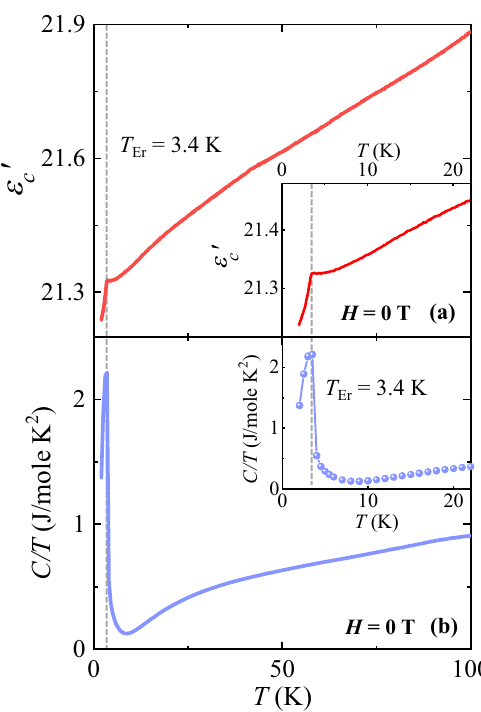
Figure 3. Temperature-dependent dielectric constant and specific heat. ( a ) Temperature dependence of dielectric constant, measured along the c axis ( ε c ′ ) at H = 0 T. Inset shows the low-temperature regime of ε c ′ . ( b ) Temperature dependence of the ratio of specific heat and temperature, C / T , measured at H = 0 T. Inset shows the low-temperature regime of C / T